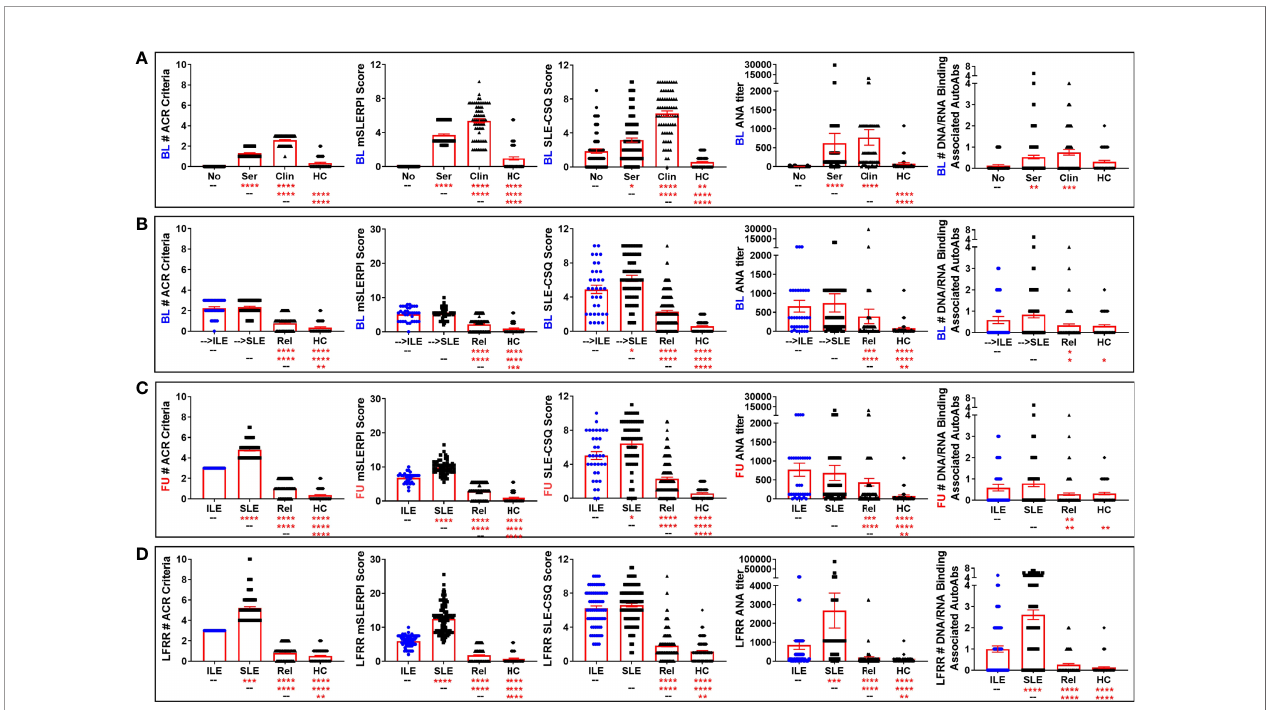
FIGURE 3 | Altered ACR and SLE-CSQ scores as well as ANA titers and autoantibody accumulation in lupus relatives who develop ILE or transition to SLE. Lupus relatives and matched healthy controls (HC) were evaluated for # of ACR criteria for SLE ( 1 st column ), modi fi ed SLE Risk Probability Index (mSLERPI) scores ( 2 nd column ), SLE-CSQ scores ( 3 rd column ), ANA titer ( 4 th column ), and # of SLE-associated autoantibody speci fi cities ( 5 th column) in (A) LAUREL cohort at baseline meeting No ACR criteria (No), only serologic ACR criteria (Ser), or clinical ACR criteria (Clin) vs. matched, unaffected HC and (B – D) lupus relatives who developed ILE (ILE), transitioned to SLE (SLE), or remained clinically unaffected (Rel) vs. matched healthy controls (HC) in (B) LAUREL cohort at baseline (pre-transition), (C) LAUREL cohort at follow-up (post-transition), and (D) LFRR con fi rmatory cohort (post-transition). Mean ± SEM. **** p<0.0001 ; *** p<0.001 ; ** p<0.01 ; * p<0.05 by Kruskal-Wallis with Dunn ’ s multiple